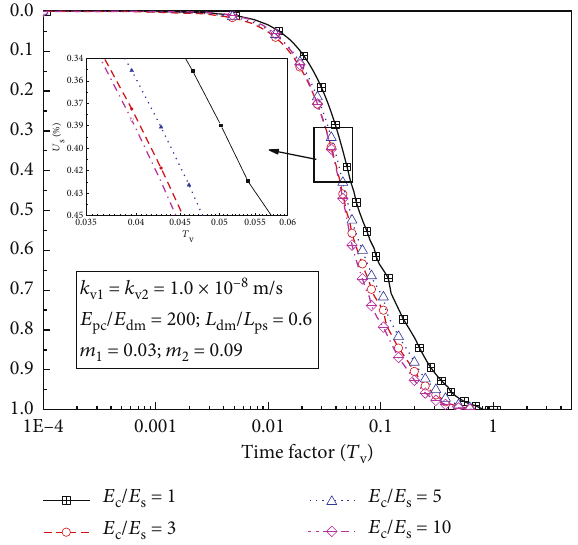
/ E on the consolidation c s